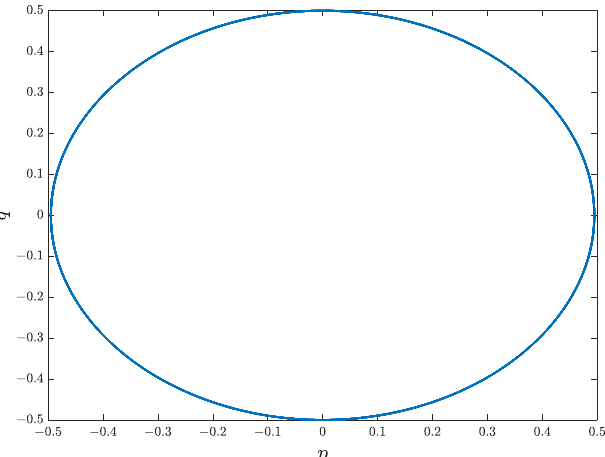
Figure 8. Phase space plot of the numerical solutions for Example 2 with h =